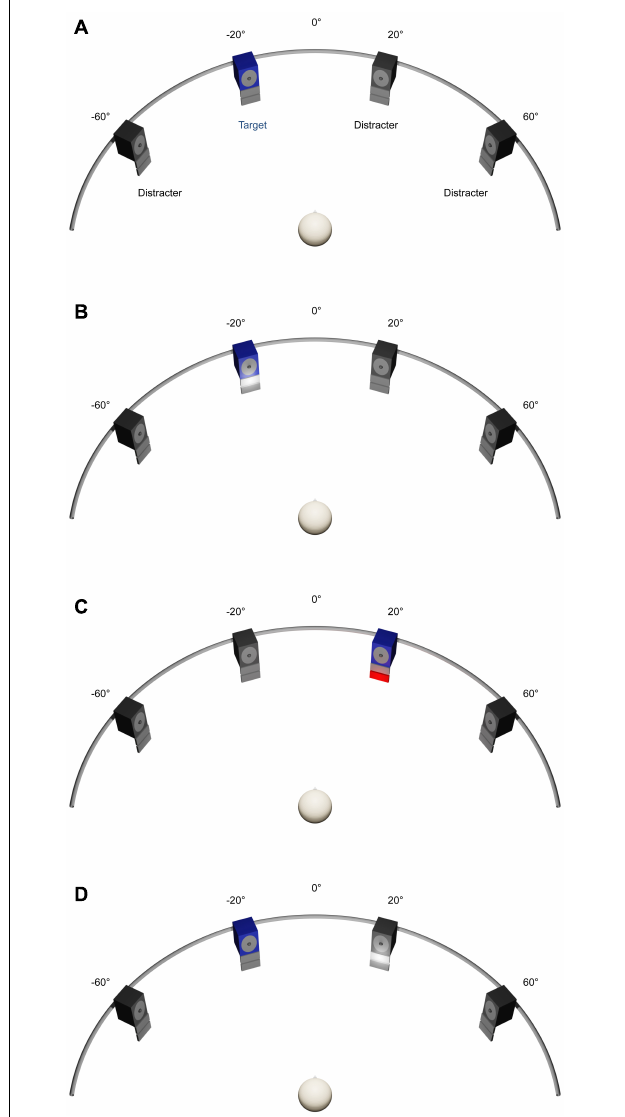
FIGURE 1 | Experimental set-up. (A) Auditory spatial attention task. Four numerals were presented simultaneously from four loudspeakers located at –60 ◦ and –20 ◦ to the left and 20 ◦ and 60 ◦ to the right. Participants had to localize a predefined target numeral by using a four-button response box. (B–D) Training Interventions. Four animal vocalizations were presented simultaneously from four loudspeakers located at –60 ◦ , − 20 ◦ , 20 ◦ , and 60 ◦ . Participants had to localize a predefined target vocalization by using the same response box as used in spatial attention task. In the audiovisual-congruency training (B) , auditory target and visual stimuli were presented in spatiotemporal alignment. In the visual-feedback training (C) , visual feedback on correct or incorrect localization was given immediately after each response. In the control condition (D) , spatially incongruent auditory target and visual stimuli were presented at random positions with synchronous